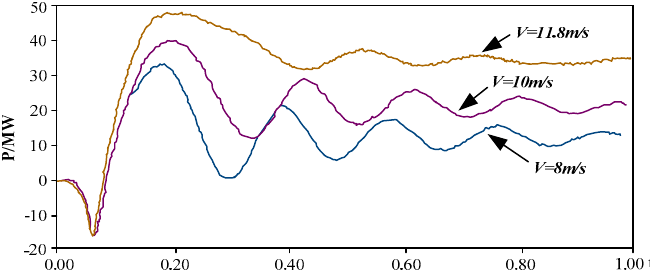
Figure 2. Output power generation by the same type of wind turbine during different wind speed.